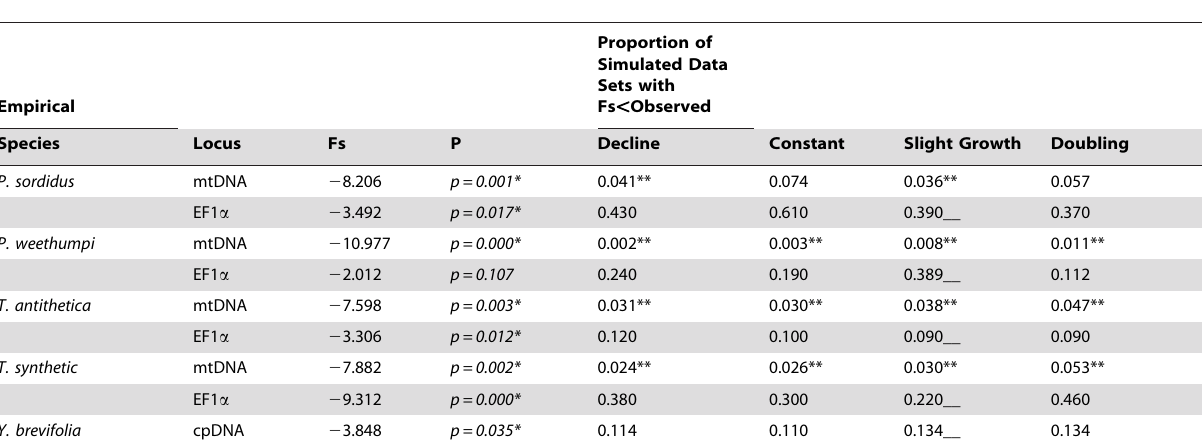
Table 5. Fu’s Fs values calculated from empirical and simulated data sets by species and by locus.